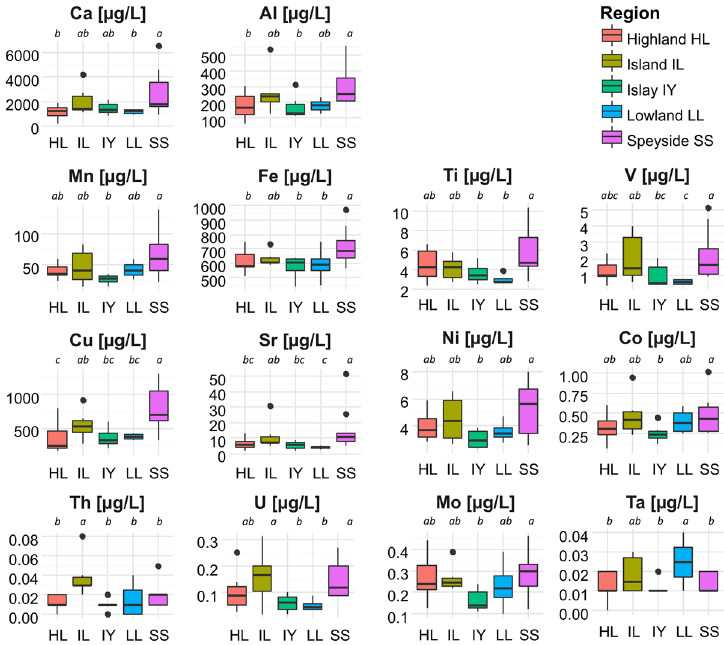
Figure 2. Boxplots of elements that differed significantly among five Scotch production areas. For each element, regions that share the same letter do not differ significantly from each other ( p < 0.05).